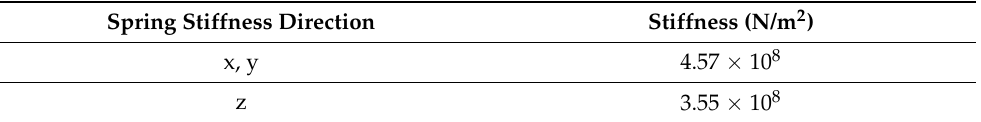
Table 2. Total spring stiffnesses.